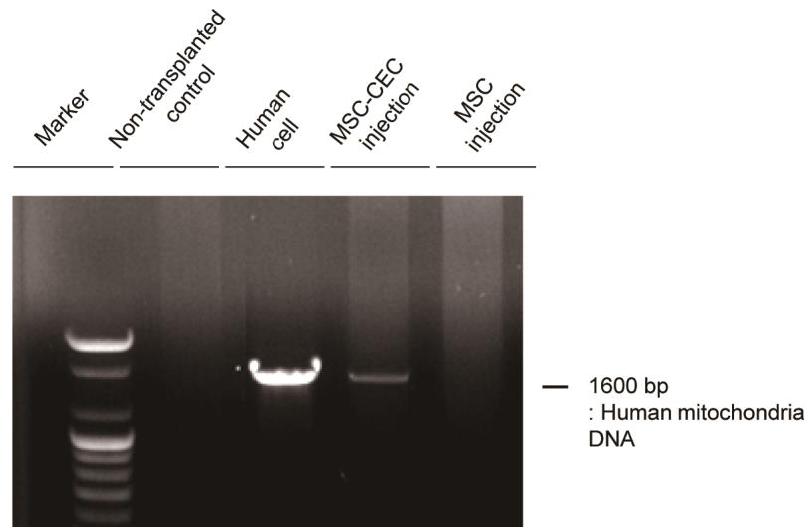
Figure 5. Engraft of human origin MSC-induced CECs after transplantation of MSC-induced CECs into corneal endothelial disease models. Gel image of RT-PCR showing human mitochondrial DNA to confirm the presence of human cells in corneal tissue after transplantation. Since human mitochondrial DNA was detected in the corneal tissue of the transplantation group, MSC-induced CECs were engrafted in the cornea after transplantation.